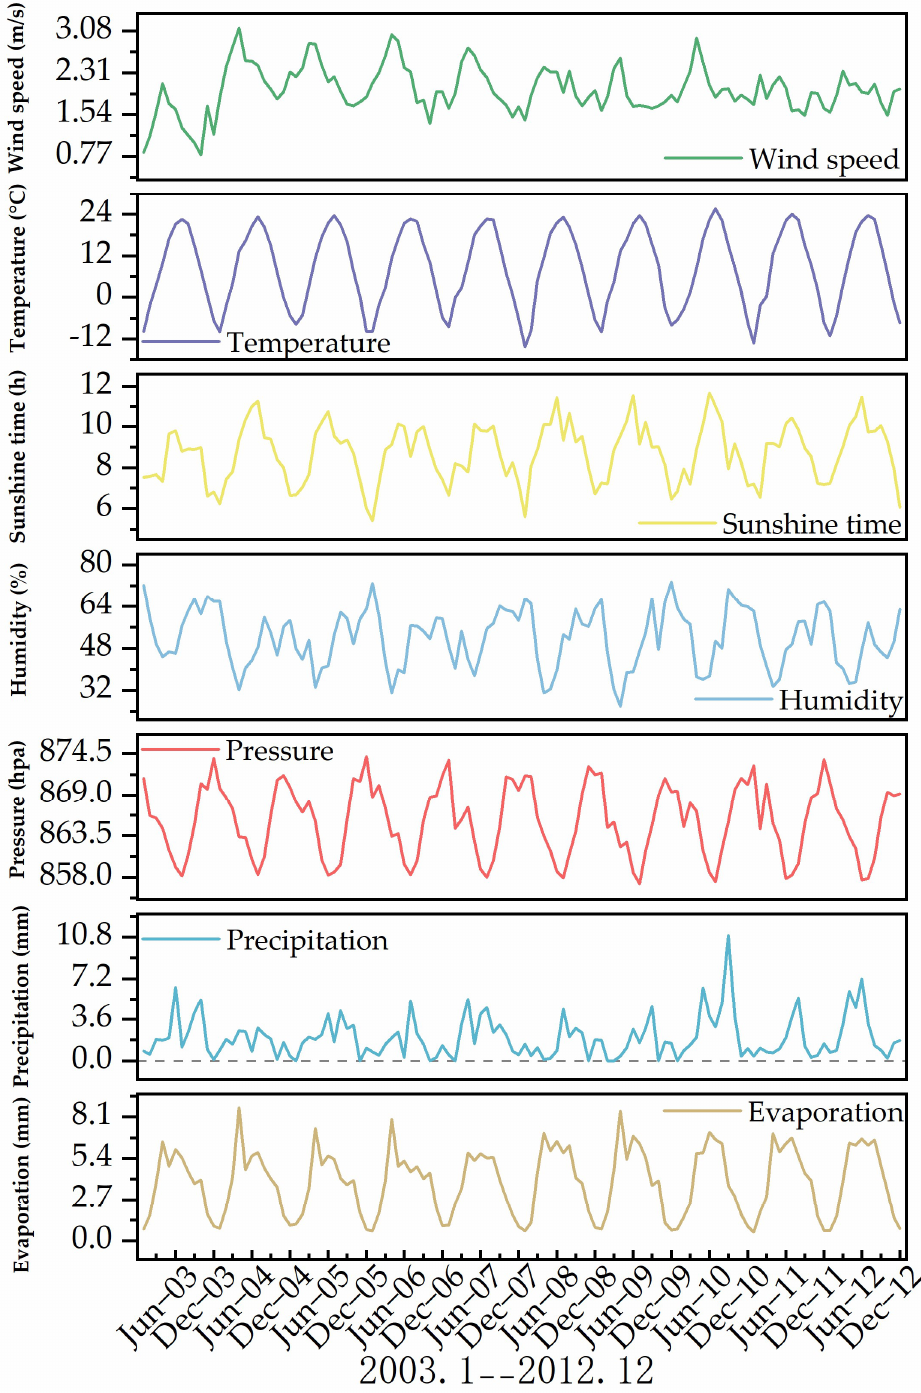
Figure 7. Multivariate meteorological factors after data processing.